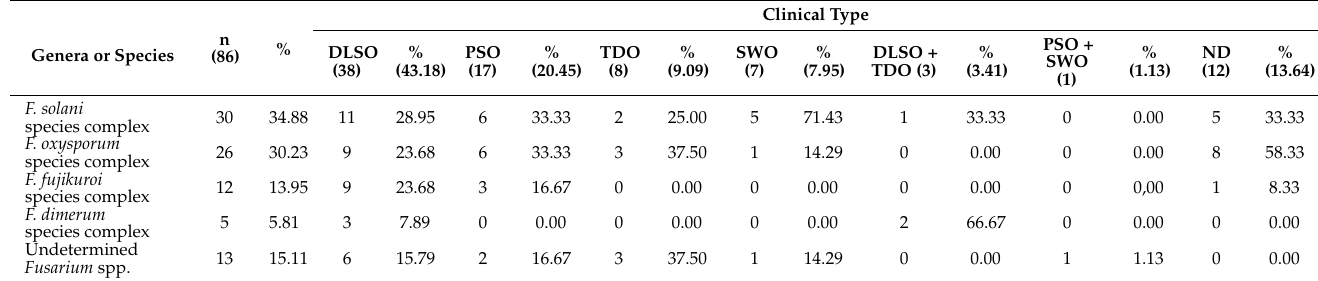
Table 3. Clinical types and corresponding Fusarium species